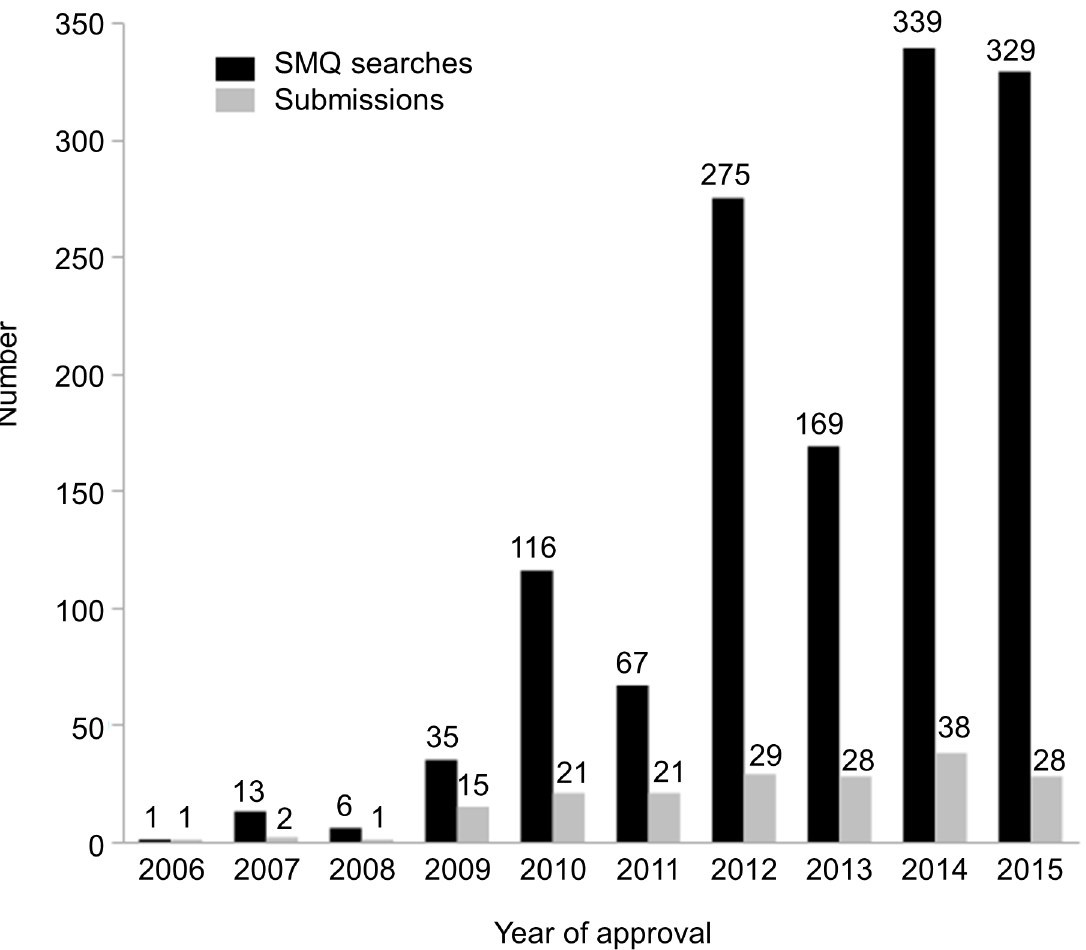
Fig 2. The numbers of Standardised MedDRA Query (SMQ) searchesand submissions per year of approval.